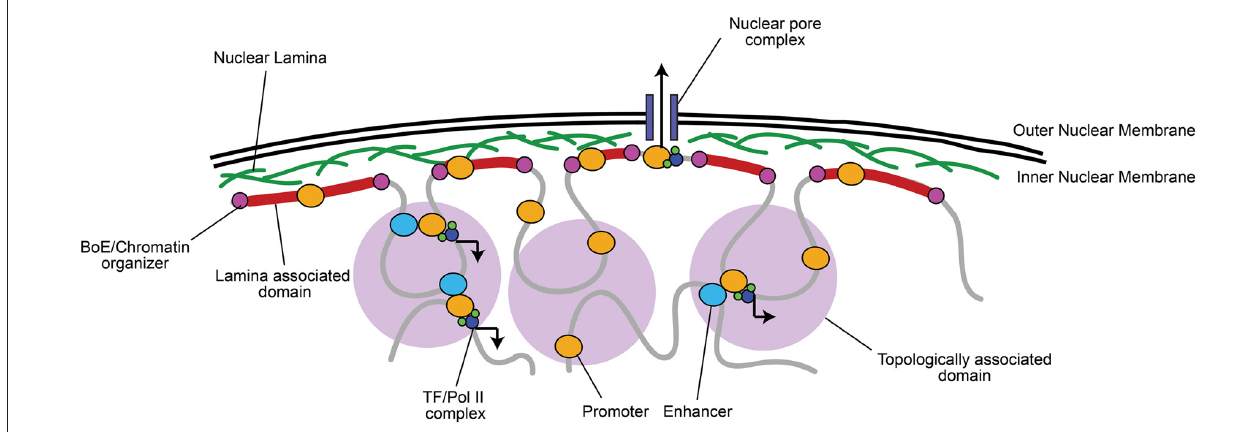
FIGURE 1 | Chromatin is organized into topologically and lamina associated domains (LADs). Chromatin is organized into large 0.1–1 megabase pair (Mb) wide topologically-associated domains (TADs), flanked by boundary elements (BoEs) that organize chromatin and allow access for chromatin modifying proteins (Dixon et al., 2012; Heidari et al., 2014; Fraser et al., 2015). Three-dimensional chromatin looping within TADs can bring non-coding regulatory elements (e.g., enhancers) to promoters, which can recruit transcriptional machinery, such as RNA Polymerase II (Pol II) and transcription factors (TFs; Dekker et al., 2002; Simonis et al., 2007; Sanyal et al., 2012). TADs found at the nuclear periphery are associated with lamin A/B, often constitutively repressed, and termed LADs (Guelen et al., 2008). A notable exception is where euchromatic regions of LADs interact with nuclear pore complexes for rapid mRNA transport to the cytoplasm (Brickner et al.,